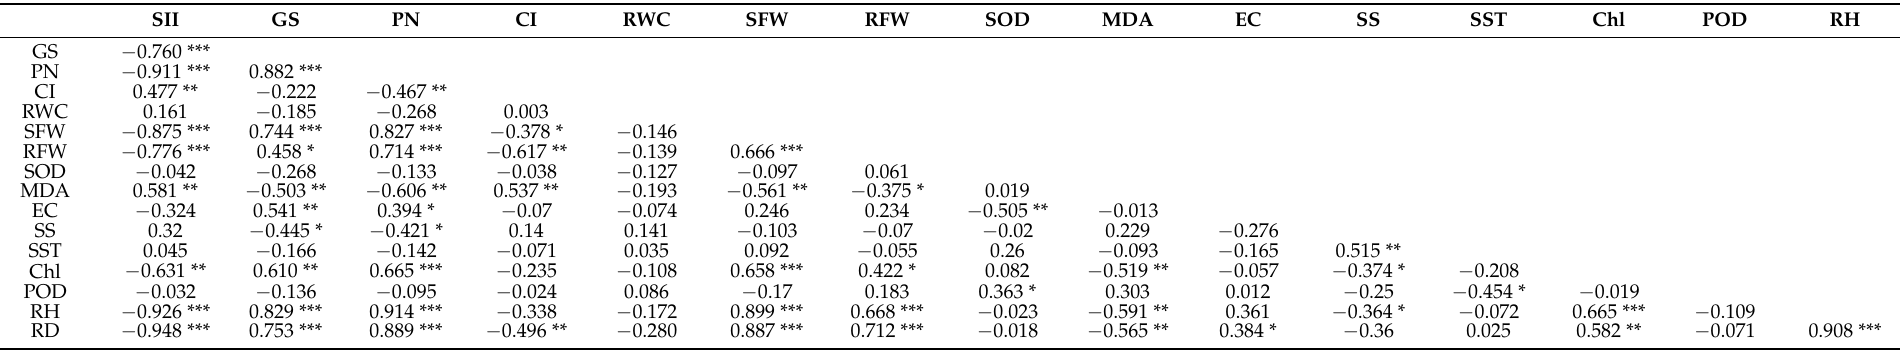
Table 3. Correlation coefficient of every single